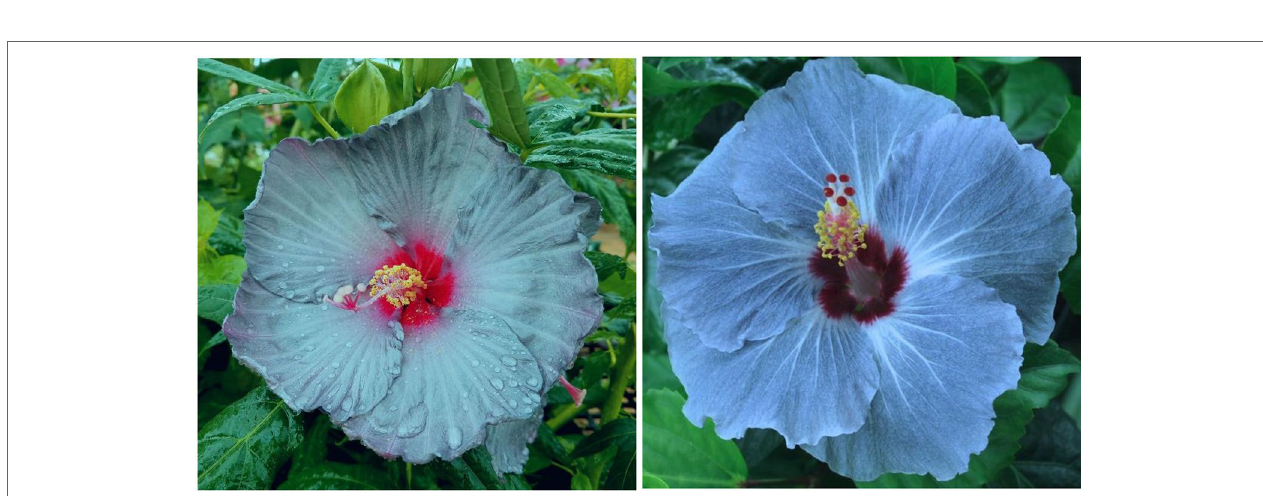
FIGURe 4 | Flower color of H. x moscheutos hybrid “TAMUS-5075” (180865 GR) (left) and H. rosa-sinensis “Blue Me Away” (right). Photo credits: Dariusz P. Malinowski (“TAMUS-5075”) and David Thompson (“Blue Me Away”). Used with permission.